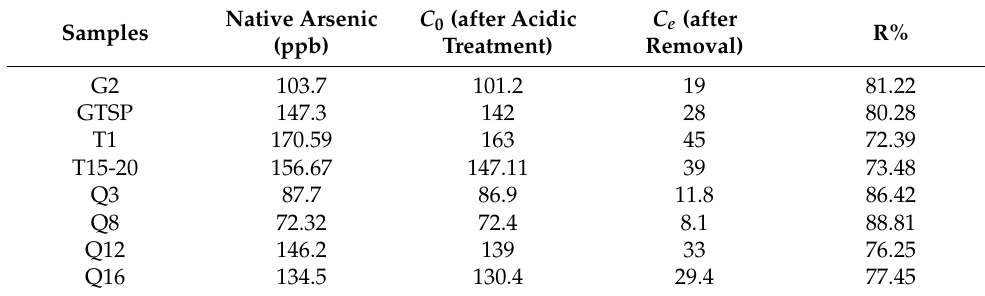
Table 5. The measurement of arsenic in different samples.